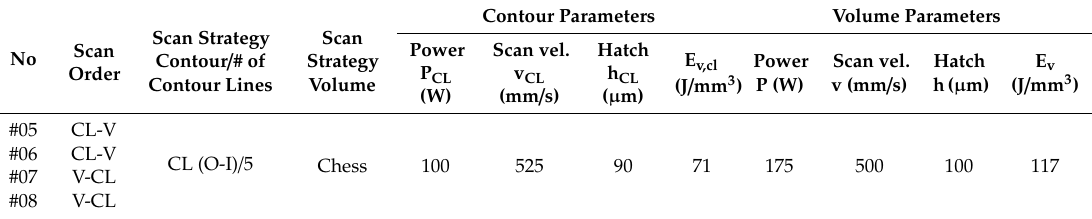
Table 2. Samples build with di ff erent scan orders.